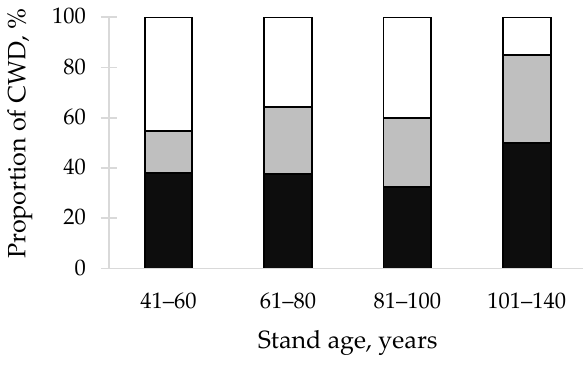
Figure 3. The proportion of coarse woody debris (CWD) by groups of species (aspen, other deciduous, and coniferous) in mature (41–60 years), moderately overmature (61–80 years), overmature (81–100 years), and old-growth (101–140 years) unmanaged European aspen ( Populus tremula L.) stands. Mean CWD diameter was 15.6 ± 1.4 cm (± standard error) in mature stands, 20.9 ± 1.4 cm in moderately overmature, 20.4 ± 1.8 cm in overmature, and 20.6 ± 0.6 cm in old-growth stands. Mature stands had a significantly thinner mean diameter of debris than old- growth stands ( p < 0.05), but similar to that in both groups of overmature stands (both p > 0.05).